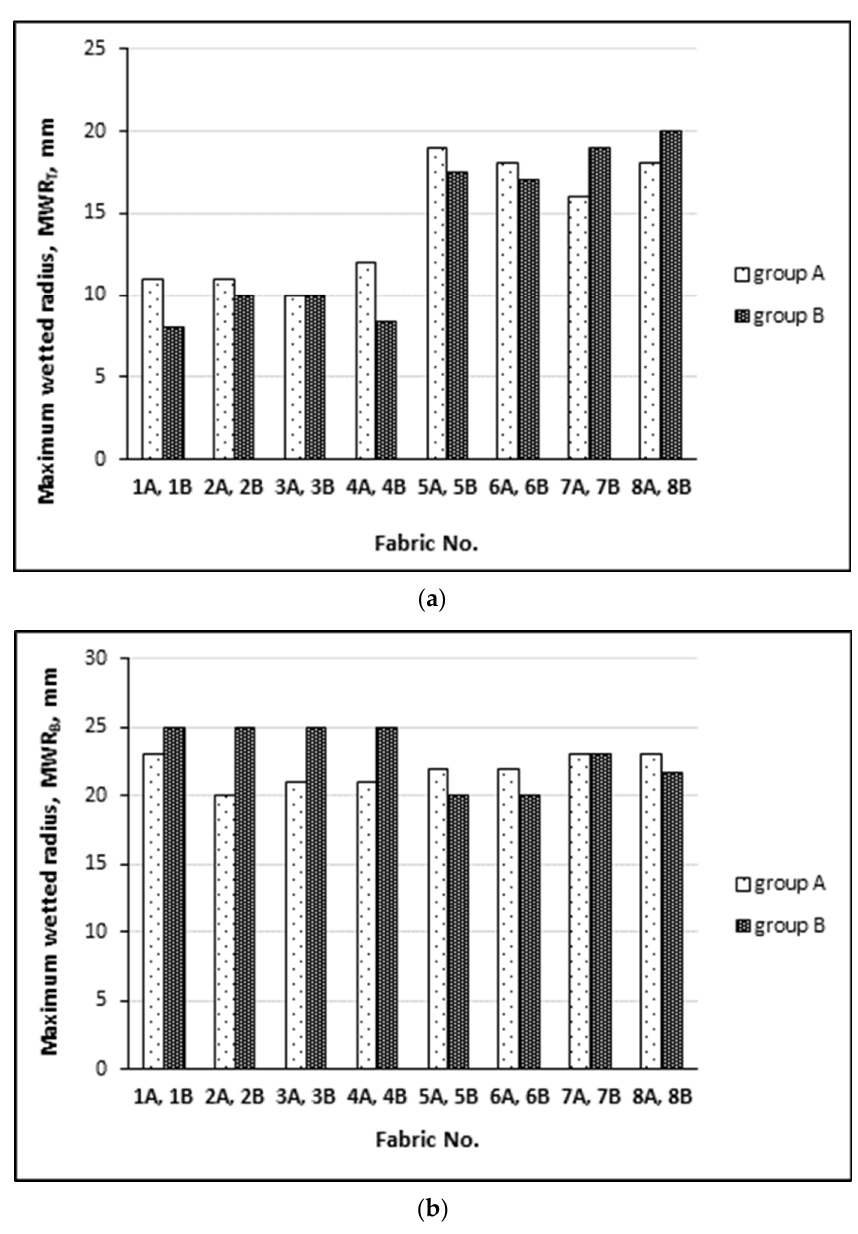
Figure 6. Maximum wetted radius on: ( a ) the inner surface of the fabrics; ( b ) the outer surface of the fabrics.